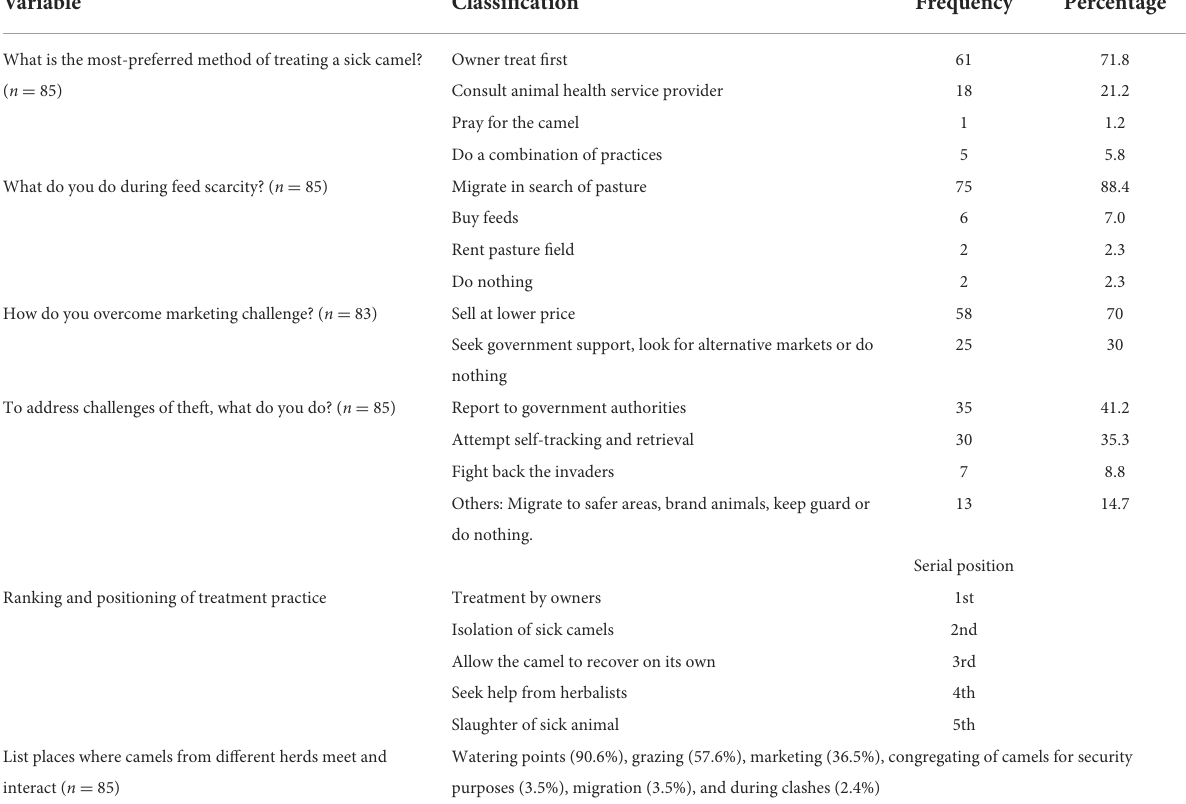
TABLE 6 Practices associated with camel management in Kenya.